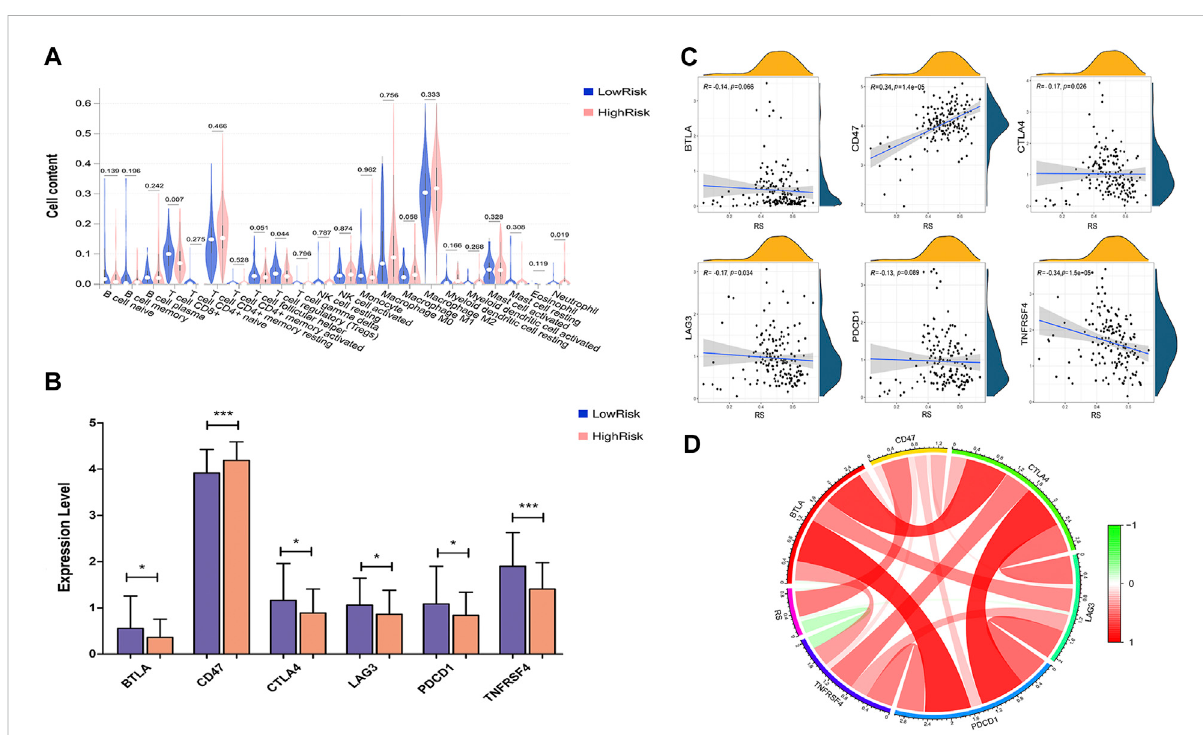
FIGURE 10 Correlation analysis between risk score and immune status. (A) The correlation between the risk score and in fi ltrating immune cells. (B) The correlation between risk score and immune checkpoint genes. (C) Correlation between risk score and immune checkpoint genes, including BTLA, CD274, CTLA4, LAG3, TNFRSF4 and PDCD1/PD-1. (D) Correlation analysis between risk score and the expression levels of immune checkpoint inhibitors. Red represents a positive correlation, and green represents a negative